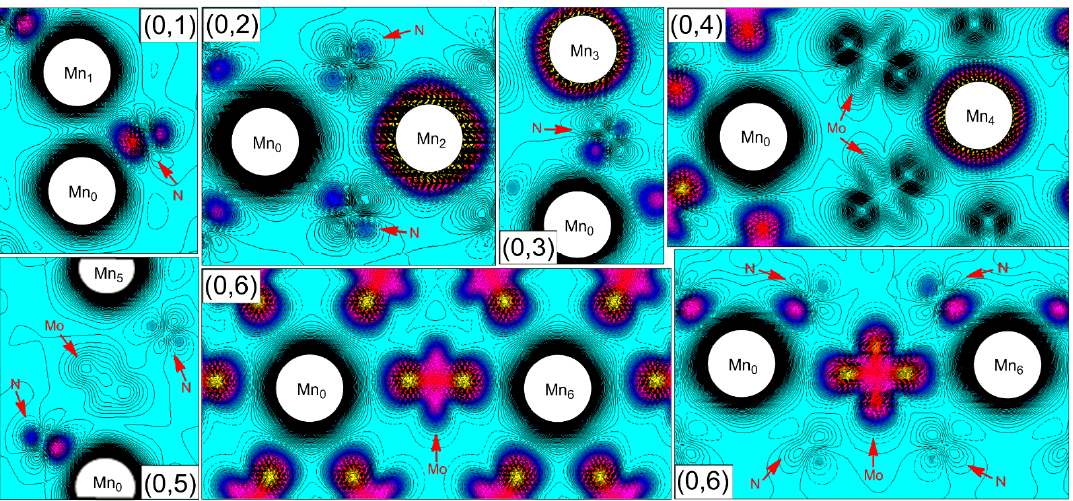
Figure 7. Spin charge density distribution on the planes containing the Mn–Mn pair and their mediating Mo and N atoms. Positive spin density is represented by solid lines, while negative spin density is represented by dashed lines and marked by colors.